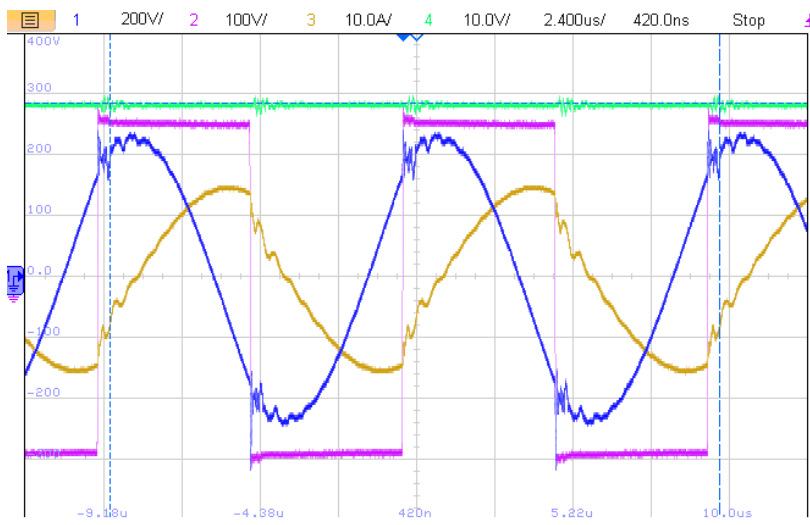
Figure 18. Experimental result of the prototype LLC converter demonstrating 1. resonant capacitor voltage (V Cr ), 2. primary side transformer voltage (V pri ), 3. resonant inductor current (I r ), and 4. output voltage (V o ) after fault.